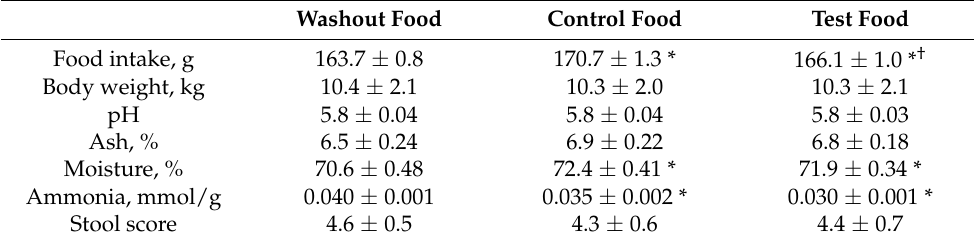
Table 2. Food intake and fecal analyses following consumption of the indicated foods.